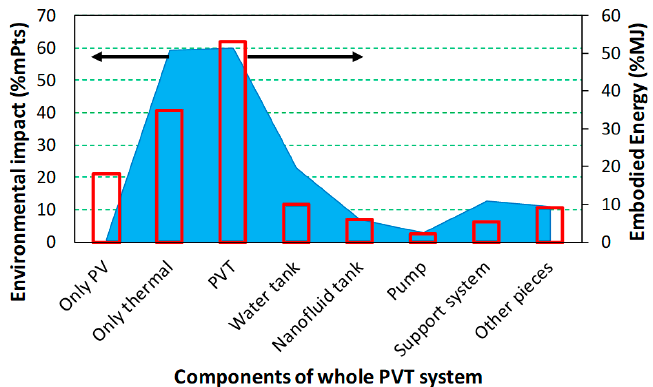
Figure 8. Percentage changes in the environmental impact vs. embodied energy in the components of the experimental setup.